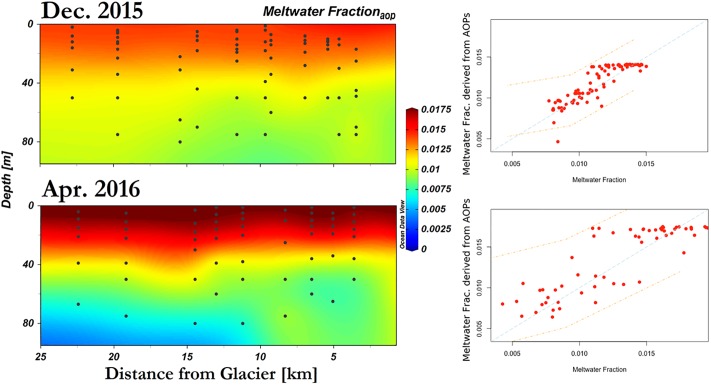
Section plots of meltwater fraction predicted based on Model 2 results.Left panels depict cross section plots of derived meltwater fraction from Model 1, which utilizes reflectance signal band ratio and addition. Right panels depict their correlation with measured meltwater fraction based on oxygen-18 isotope ratios; orange dash lines indicate predication intervals at 95% confidence.